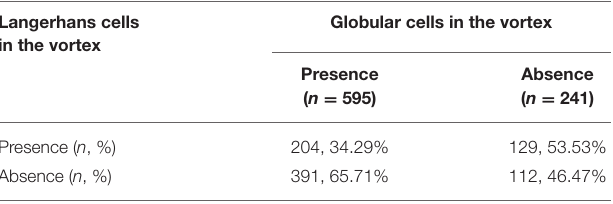
TABLE 2 | Distribution of the globular cells and Langerhans cells in the corneal nerve vortex.